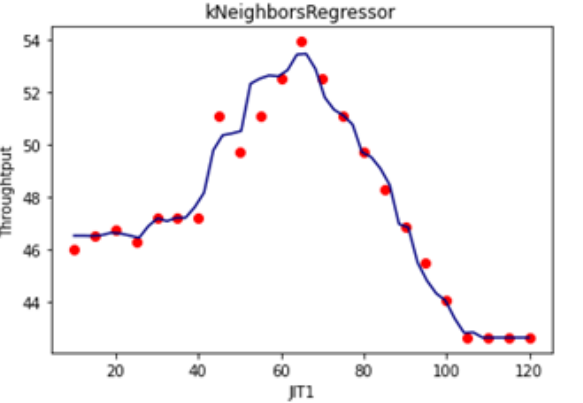
Figure 6. Throughput prediction through KNN regression (process_time = 135, WAC_time = 40).